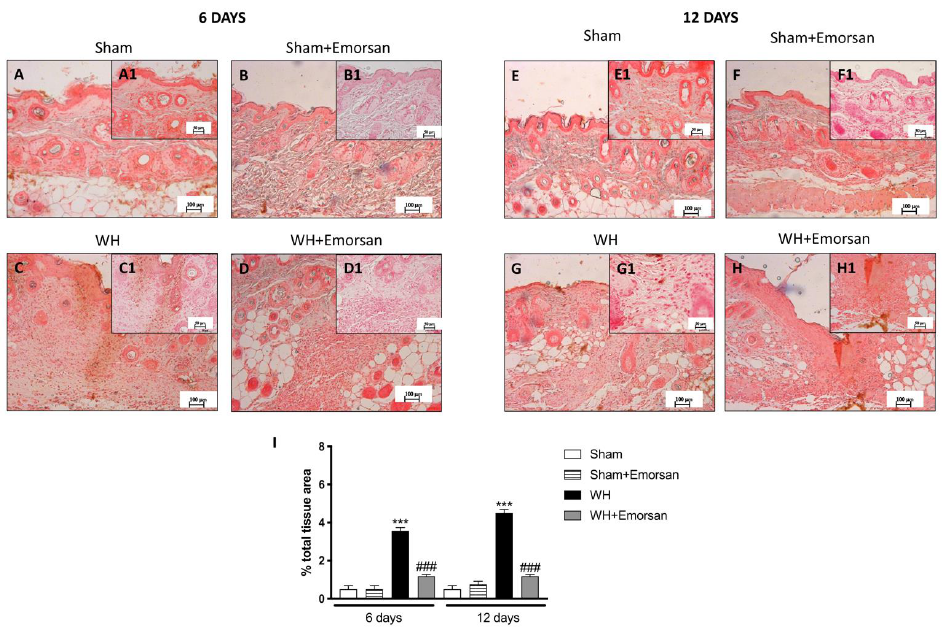
Figure 8. Effect of Emorsan ® Gel treatment on ICAM-1 expression after WH. Epidermal tissues Figure 8. obtained from WH-injured animals exhibited positive immunostaining for ICAM-1 ( C , C1 , G , G1 ,score I ), compared to the sham-treated animals ( A , A1 , B , B1 , E , E1 , F , F1 ,score I ). Emorsan ® Gel administered topically reduced this expression in both times ( D , D1 , H , H1 ,score I ). Data are rep- resentative of at least three independent experiments. Values are means ± SEM. One-Way ANOVA test. *** p < 0.001 vs. corresponding Sham; ### p < 0.001 vs. corresponding WH.